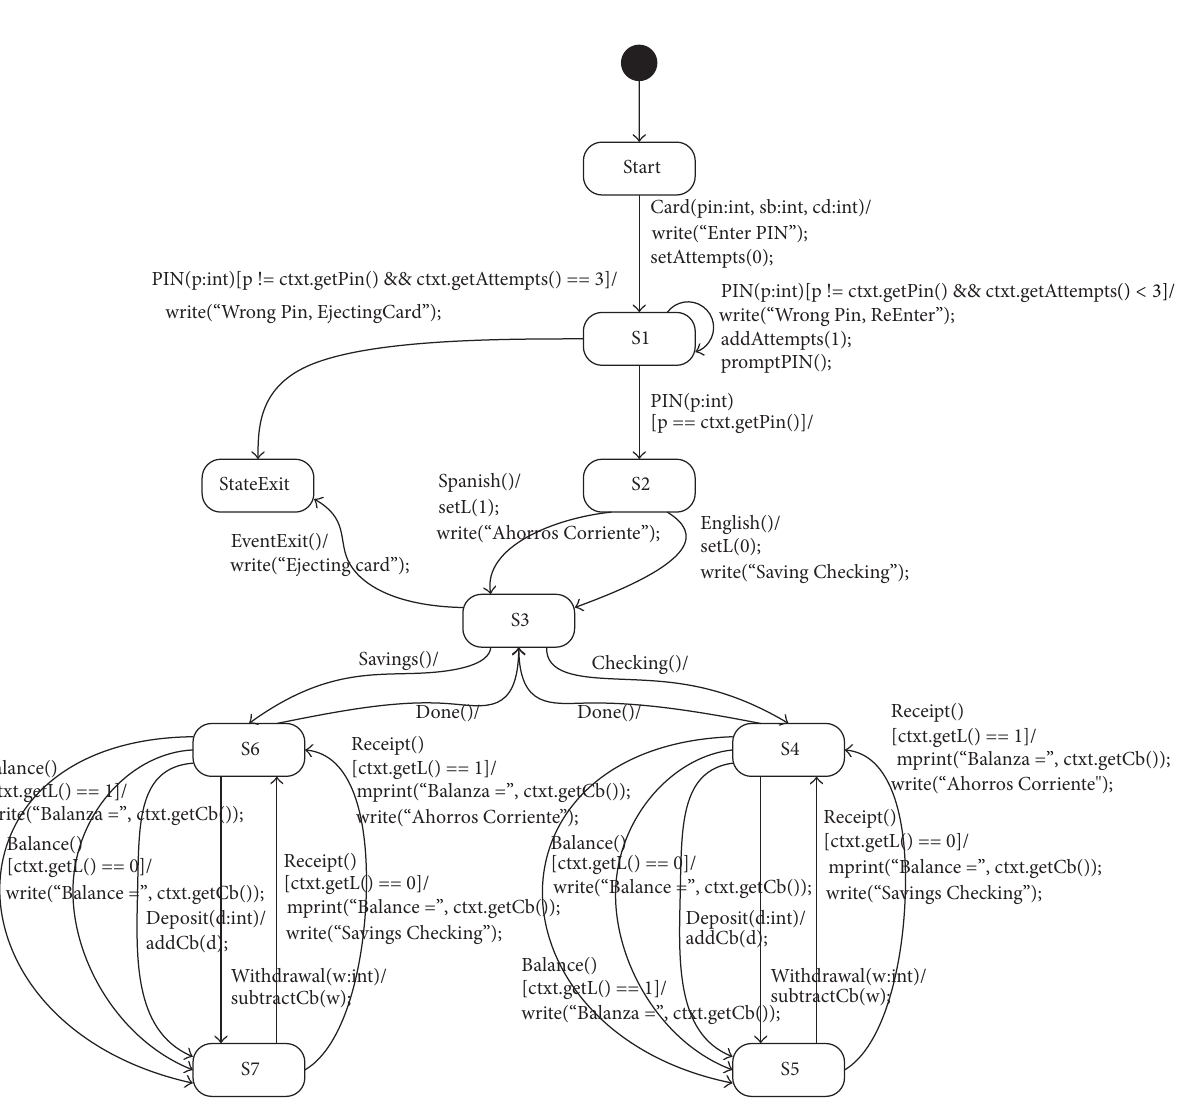
Figure 2: Sample of EFSM model: automatic teller